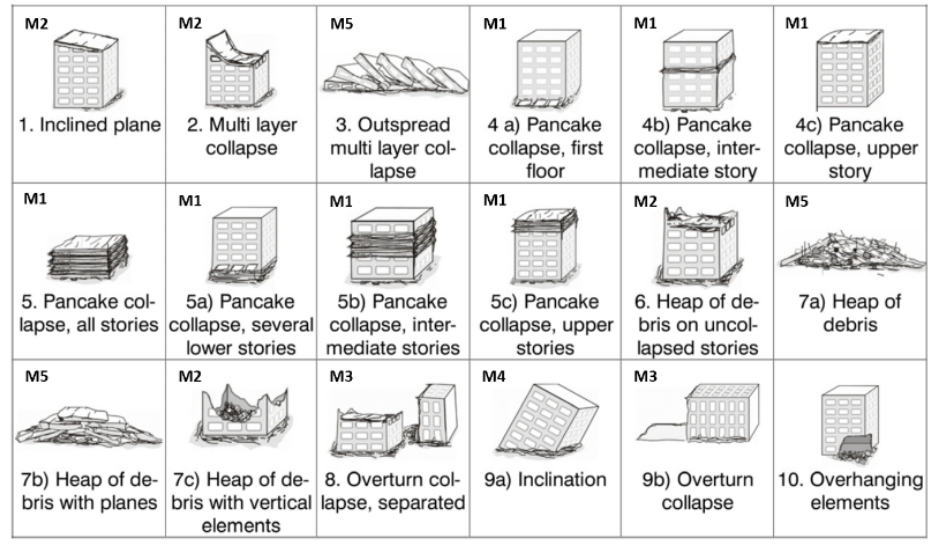
Figure 1. Building damage models regrouped from the earthquake-induced building damage classification by Schweier and Markus [26] (Reprinted with permission from ref. [26]. Copyright 2004, Michael Markus).